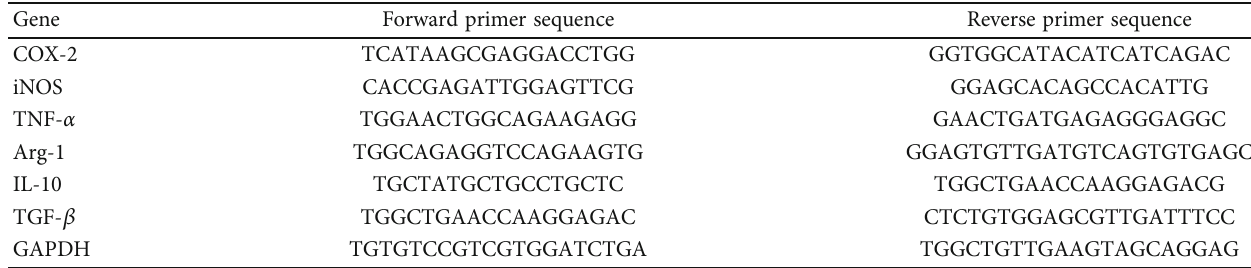
Figure 2: Timeline of the experimental protocol. Table 1: Primer sequences for